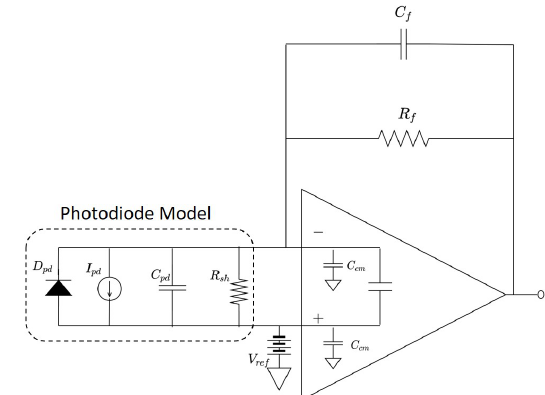
Figure 3. Transimpedance amplifier.